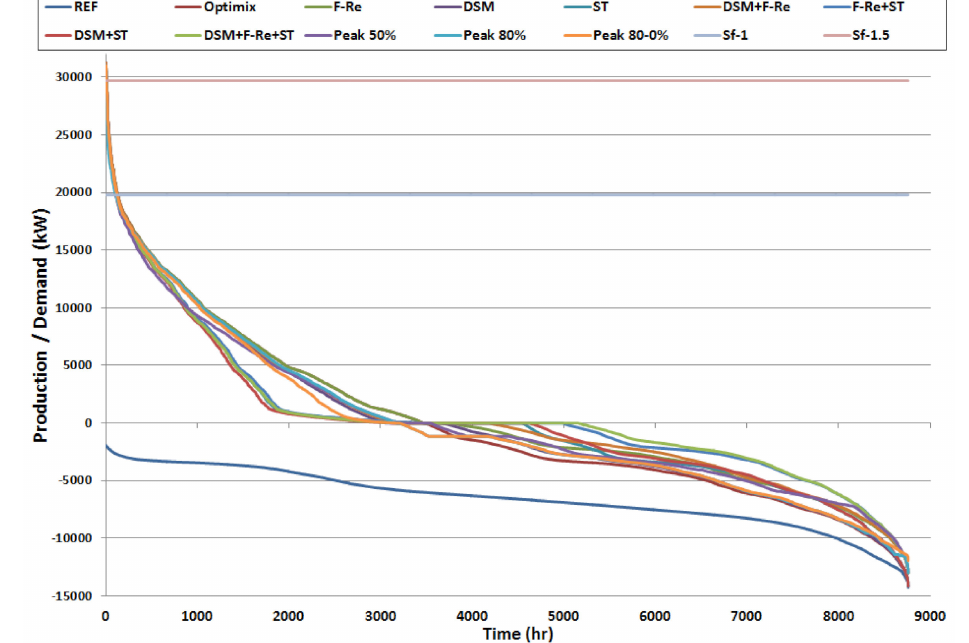
Figure A10. Main LDC results from the renewable integration and peak shaving scenarios.